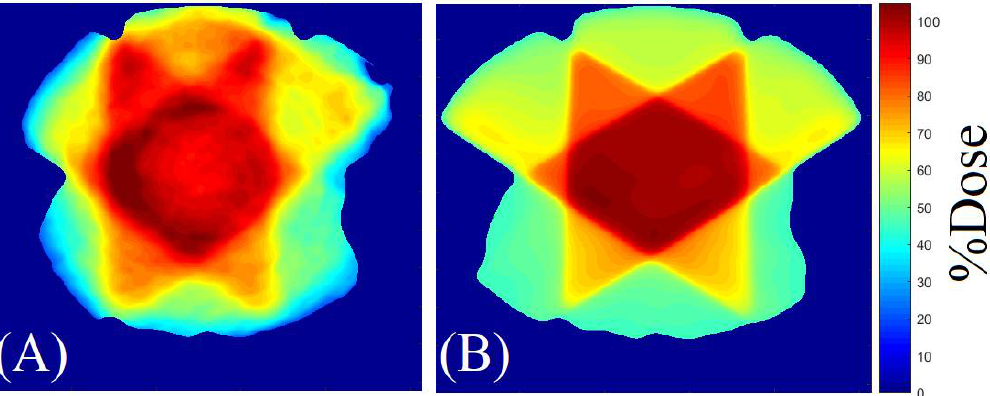
Figure 3. Dose distribution measured by the gel dosimeter with OCT scanning ( A ), and the corresponding slice (6.3 cm) calculated by the TPS ( B )—20% of threshold.